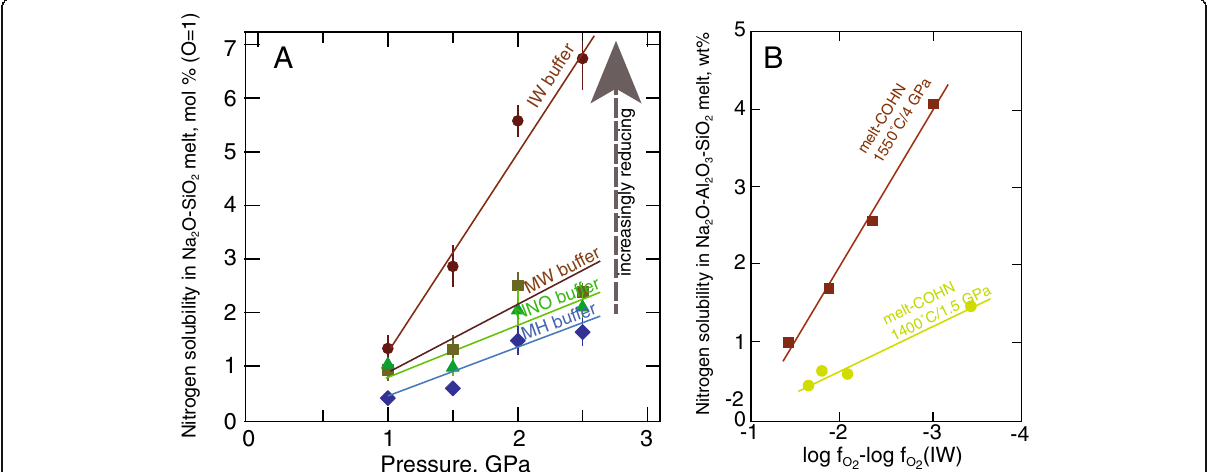
Fig. 18 Nitrogen solubility in alkali aluminosilicate melts as a function of pressure at different oxygen buffers. a At oxygen fugacity above that of the IW buffer (data from Mysen et al. 2008). b Data at oxygen fugacity below that of the IW buffer (data from Kadik et al. 2011, 2013, 2015)